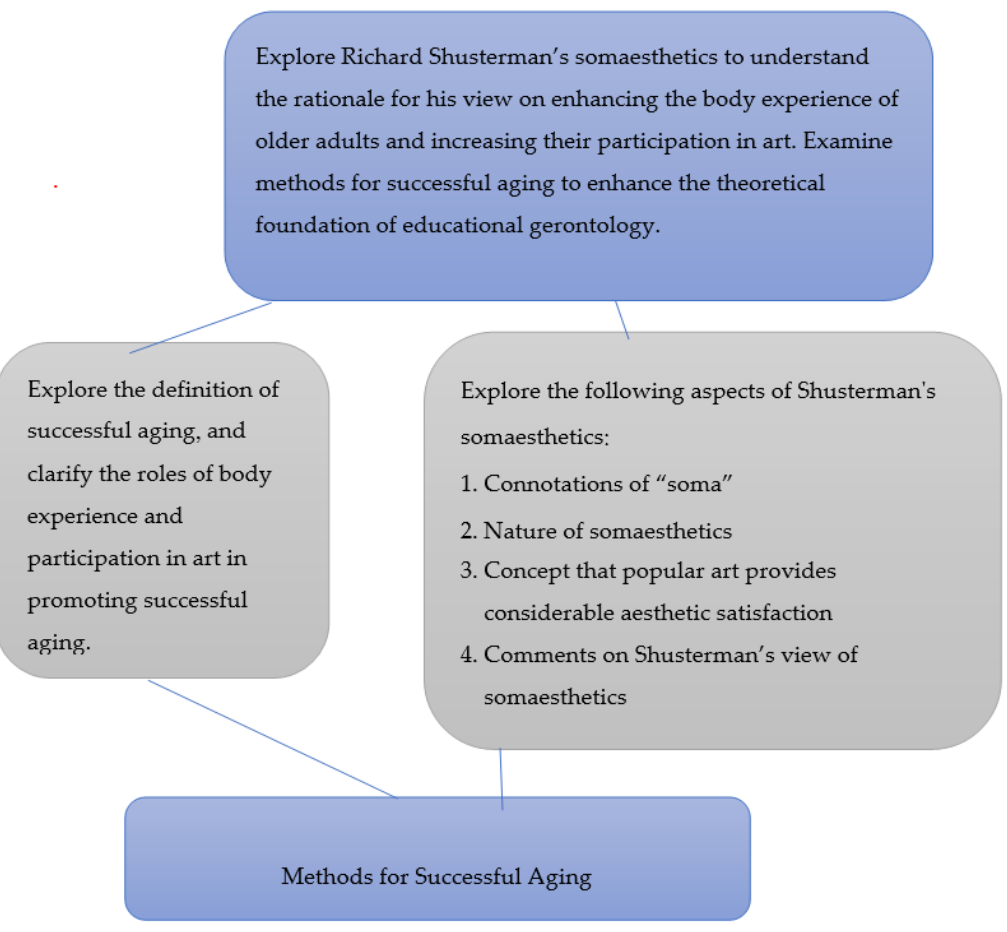
Figure 1. The conceptual framework. Source: Created in the present study.